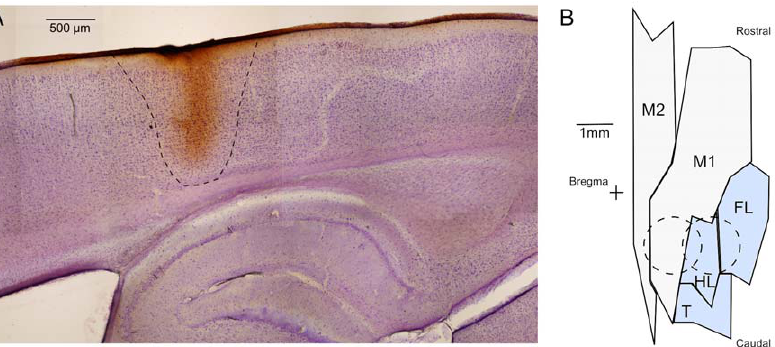
Figure 3. Spread of biotinylated ZIP injections in the sensorimotor cortex. A) Histology showing the extent of diffusion of biotinylated ZIP. Average maximal diffusion of 4 injections is shown by dashed line. There is no diffusion of the biotinylated ZIP to the hippocampus or subcortical structures. Counterstain is cresyl violet. B) Illustration of the diffusion within a single hemisphere from sensorimotor injections sites (dashed circles), mapped onto motor (grey) and sensory (blue) areas: M1, primary motor; M2, secondary motor; and primary sensory (S1) regions, including FL, forelimb; HL, hindlimb; T, trunk; based on [14,15].